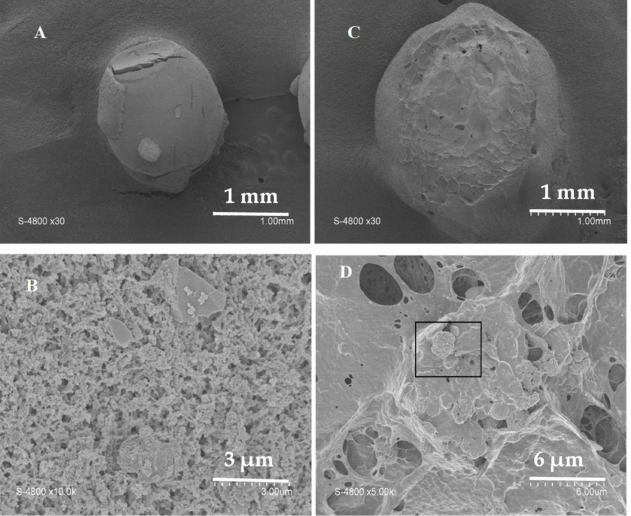
Figure 1. SEM micrograph of pure C ( A , B ) and C-LDH(1) beads ( C , D ).